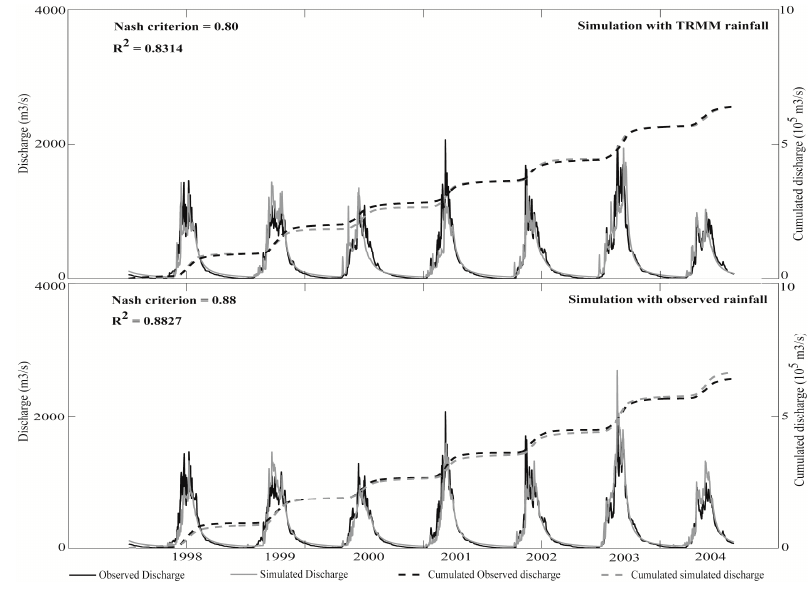
Figure 6. Observed and calculated discharge.